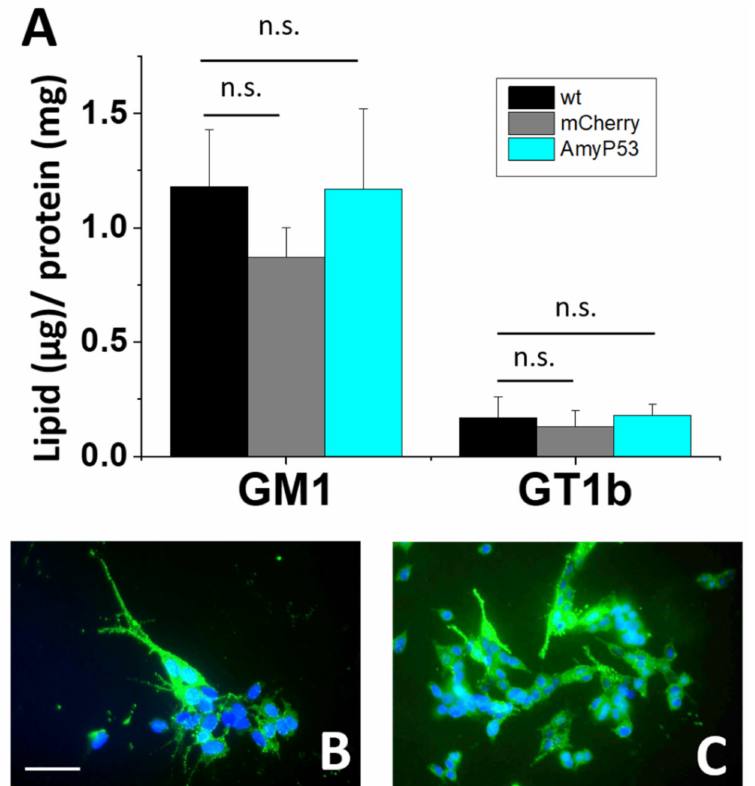
Figure 6. Non-transfected SH-SY5Y and SH-SY5Y-AmyP53 cells have similar ganglioside expression levels. ( A ) HPTLC quantification of gangliosides GM1 and GT1b in non-transfected SH-SY5Y cells (wt) compared with transfected SH-SY5Y-mCherry and SH-SY5Y-AmyP53 cells. Results are expressed as mean ± SEM. Kruskal–Wallis test was used to compare the statistical significance. n.s. > 0.05; n = 3. ( B ) Immunofluorescence detection of ganglioside GM1 in non-transfected SH-SY5Y cells. ( C ) Immunofluorescence detection of ganglioside GM1 in SH-SY5Y-AmyP53 cells. The pictures are representative of three independent experiments. Scale bar: 100 µ